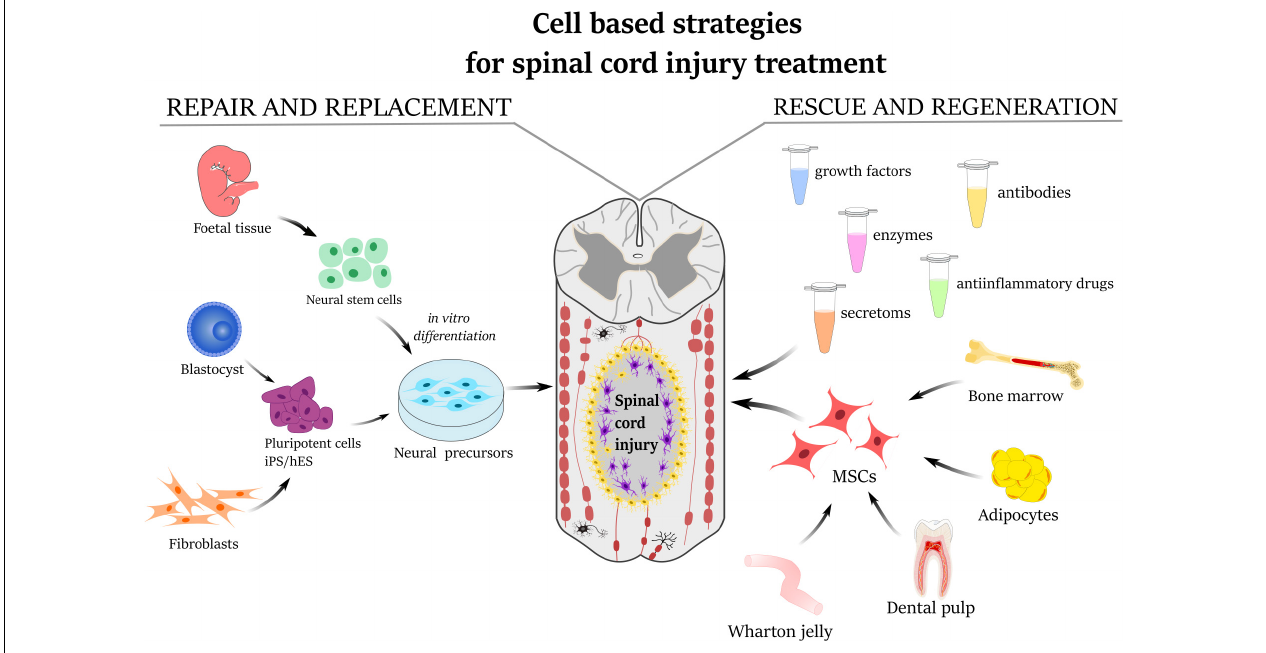
FIGURE 1 | Schematic illustration describing the strategies for the treatment of spinal cord injury. Repair and replacement of damaged tissue by neural precursors derived either from fetal neural tissue or from induced pluripotent stem cells (iPS/hES). The mesenchymal stem cells derived from bone marrow, adipose tissue, dental pulp, or umbilical cord Wharton’s jelly have a rescue-and-regeneration effect mediated by paracrine action through releasing secretomes, growth factors, anti-inflammatory molecules as well as enzymes and